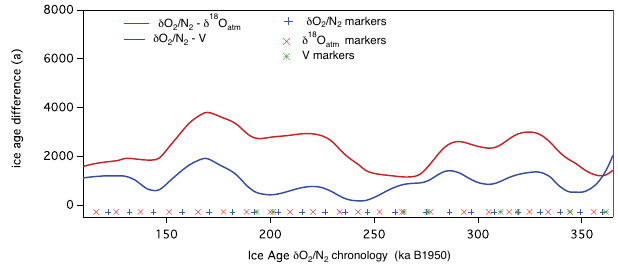
Fig. 4. Ice age difference between the δ O 2 / N 2 and air content (V) chronologies (blue) and δ O 2 / N 2 and δ 18 O atm chronologies (red) on the Vostok ice core. The different markers show the position of the orbital age constraints for each chronology.